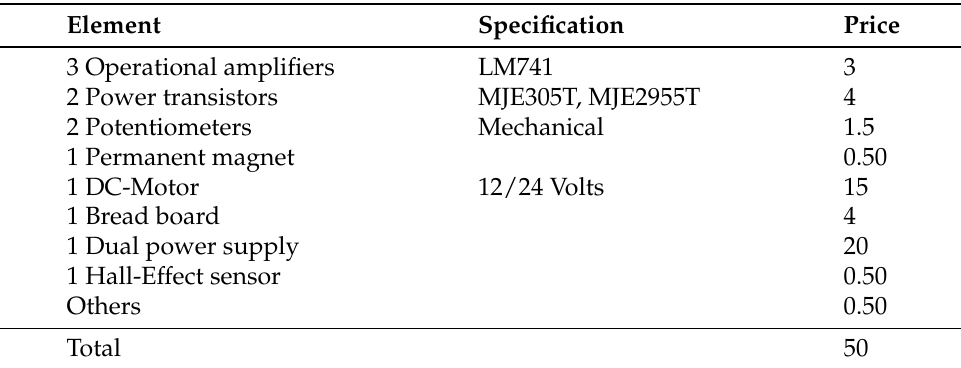
Figure 19. Actuator dead-zone nonlinearity. Table 1. Electronic components list and estimation cost in